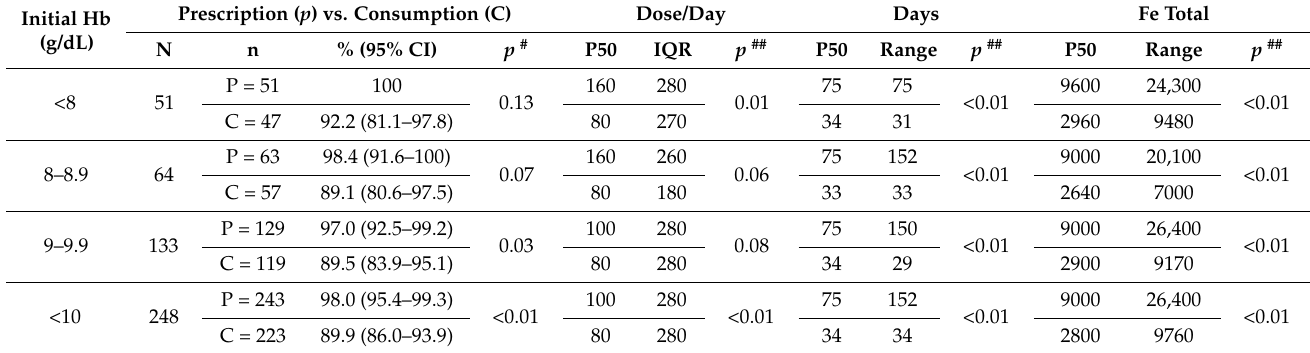
Table 3. Description of the prescribed regimen and the actual iron consumption of 1019 postpartum women (6 weeks). Initial Hb